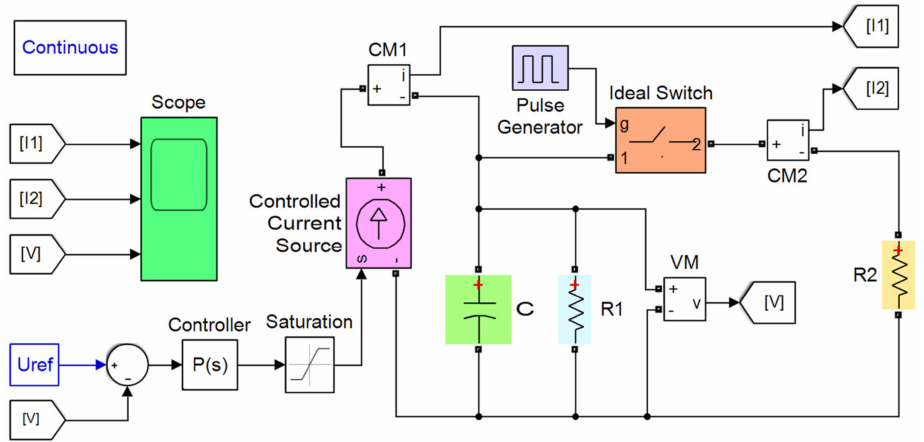
Figure 12. Simulation model of the WSN power supply